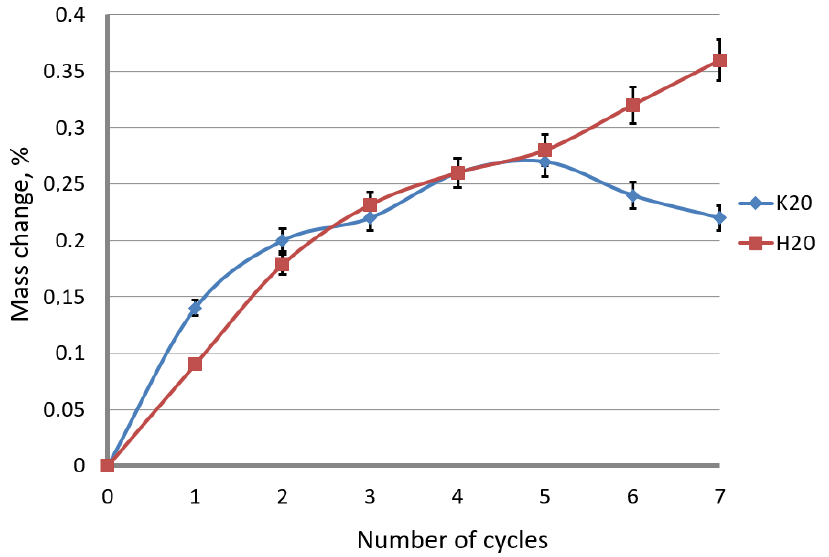
Figure 9. The mass change of the galvanized wires drawn with the conventional (K20) and hydrodynamic (H20) method with the speed of 20 m/s as a function of the number of exposure cycles in the sulfur dioxide chamber.